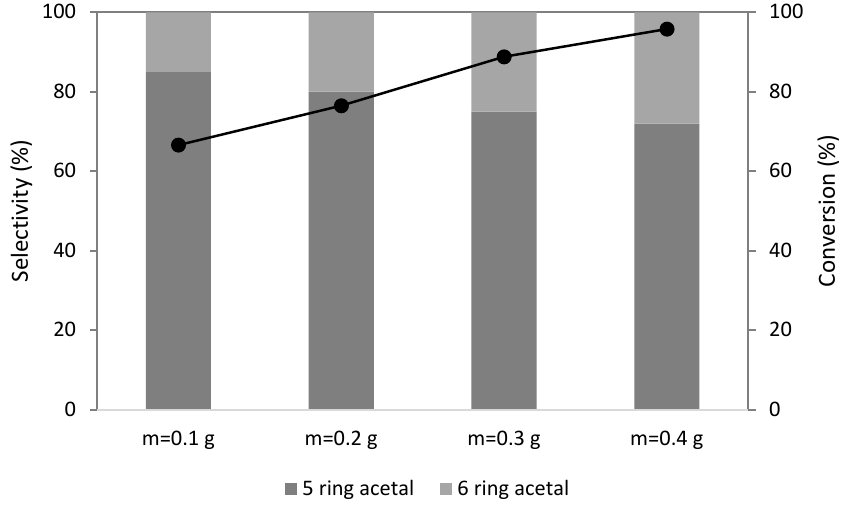
Figure 9. Acetalization of glycerol with citral over PW4-K-6. Effect of catalyst amount after 5 h of reaction.